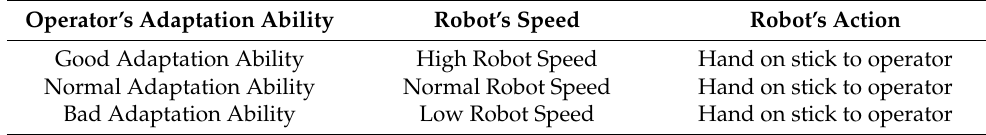
Table 4. Robot’s Decision Speed Depending on the Operator’s Adaptation Ability.